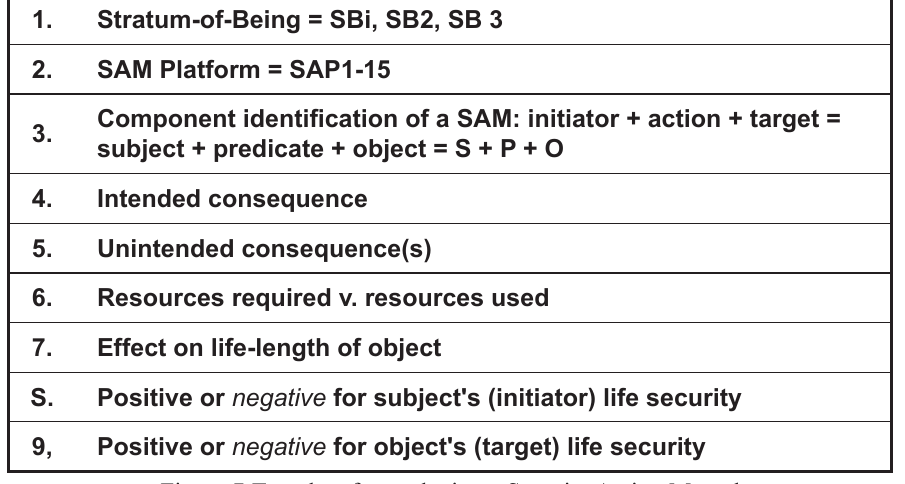
Figure 7:Template for analyzing a Security Action